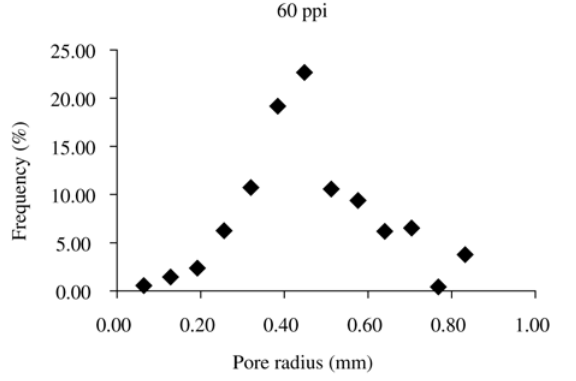
Figure 6. 60 ppi ceramic foam pore size distribution.